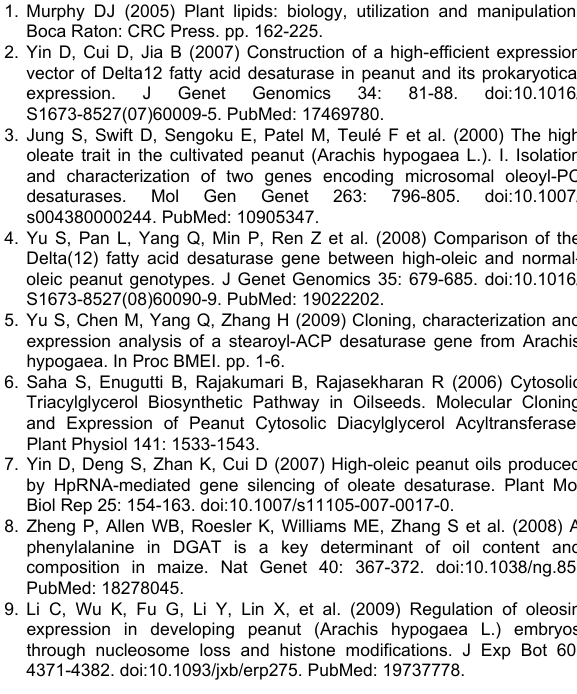
Figure S1. The distribution of Unigenes based on length. (TIF) Table S1. The distribution of contigs and Unigenes in each library. Table S2. A histogram of clusters of orthologous groups (COG) classification Table S3. Unigene Metabolic Pathway Analysis. Table S4. The list of 606-3 vs. 12-3 differentially expressed Table S5. The list of 606-5 vs. 12-5 differentially expressed